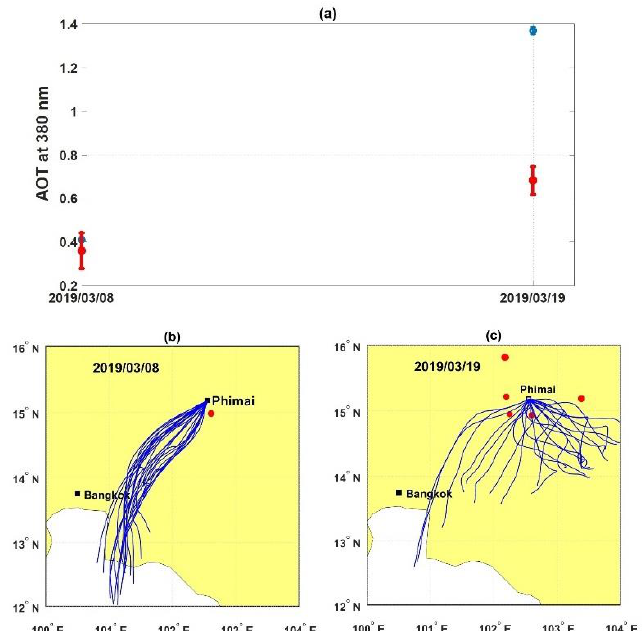
Figure 8. ( a ) The sky radiometer and GCOM-C AOT values at 380 nm in Phimai on March 8 and 19. The error bars indicate the 1 σ standard deviation. 24 h backward trajectories, starting from 200 m above ground level over the Phimai site on ( b ) March 8 and ( c ) March 19, 2019. The red dots indicate the fire activities within 100 km of the Phimai site.